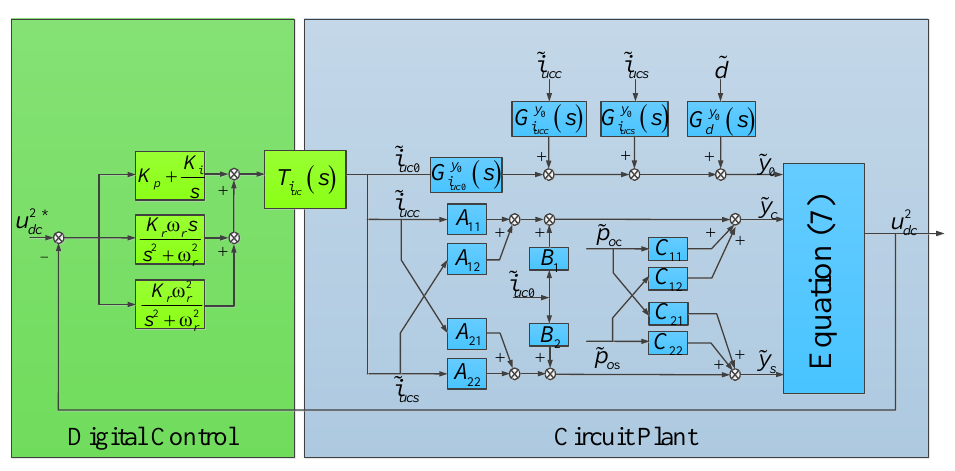
Figure 2. Control scheme for the